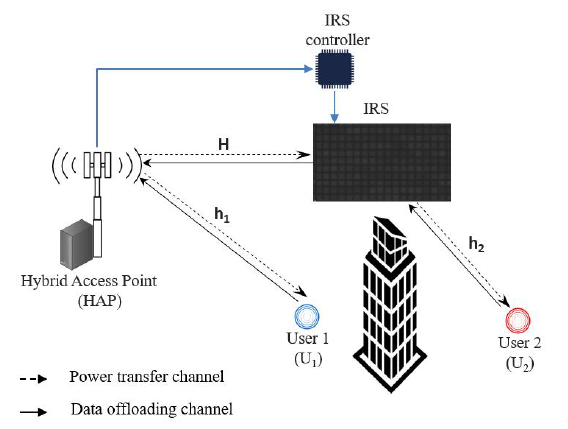
Figure 1. System Model for RF Energy Harvesting IRS- assisted MEC Network